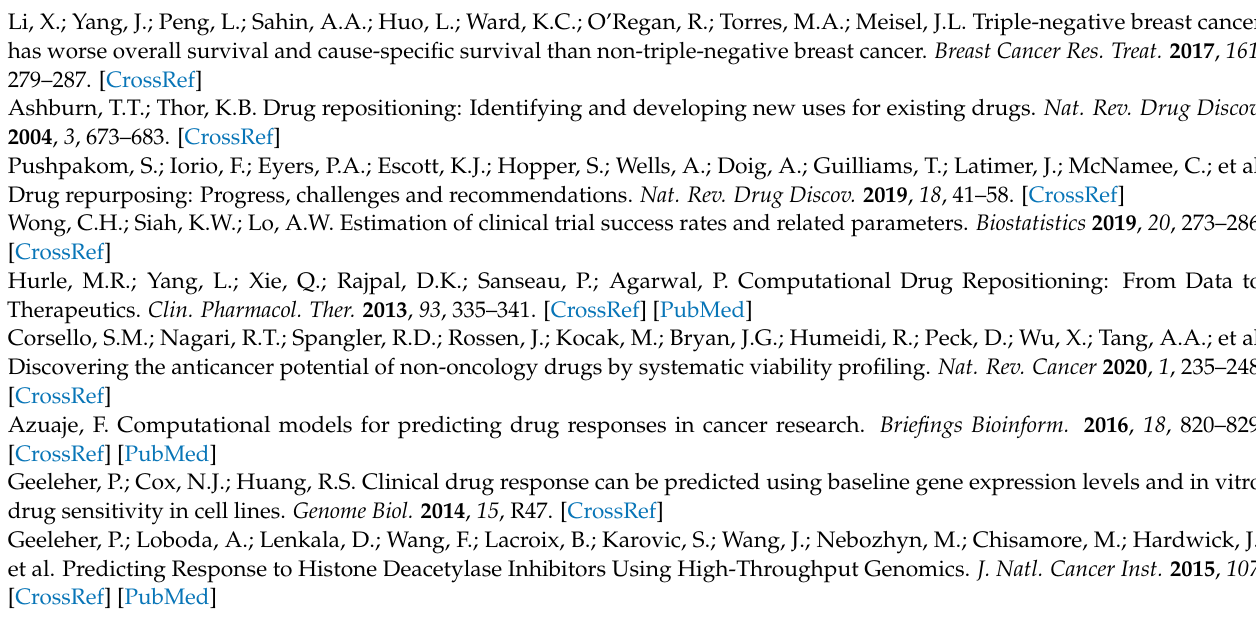
Response, Figure S5: Validation of AZD-1775 potency in TNBC cell lines, Table S1: Table of patient imputed sensitivity to CTRP drugs, Table S2: Table of t-test results for effectiveness in TNBC for each drug in the CTRP based on imputed sensitivity scores in the TCGA BRCA cohort, Table S3:. Literature evidence for top drugs identified by the differential imputed sensitivity analysis. Table S4: Gene Set Enrichment Analysis (GSEA) results Table S5: Imputed-drug wide association results for AZD-1775 in BRCA, Table S6: Associations of drug sensitivity and TP53 mutations in GDSC cell lines, Table S7: Imputed-drug wide association results for all drugs in